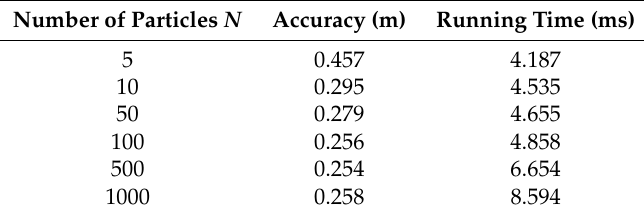
Table 3. Mean positioning accuracy and running time of the algorithm under the impact of different number of particles N